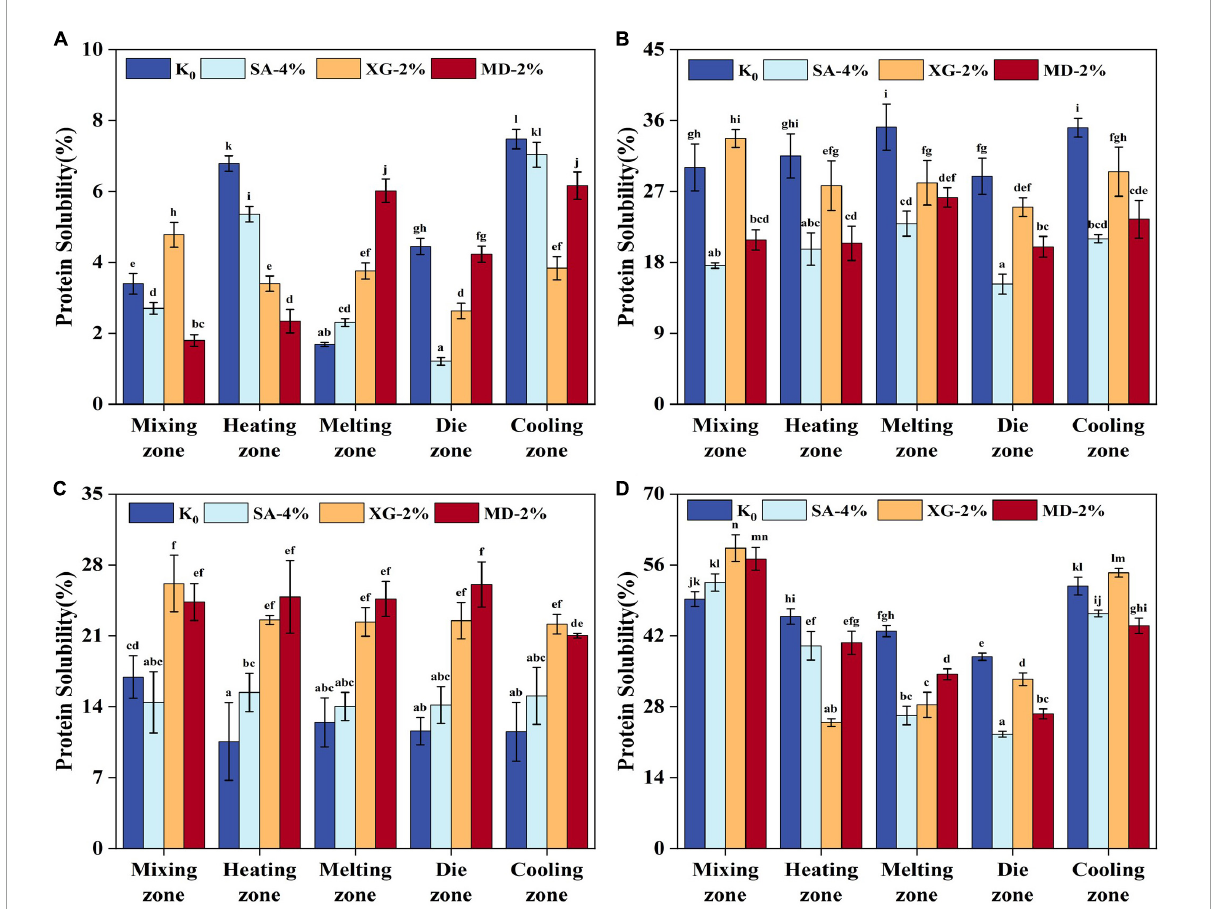
FIGURE7 Protein solubility of the extrudates in different zones (Mixing zone, Heating zone, Melting zone, Die zone, and Cooling zone) induced by extracting solutions: (A) Phosphate buffer (pH = 7.5, 0.1 mol/L). (B) 8.0 M urea in phosphate buffer (pH = 7.5, 0.1 mol/L). (C) 0.05 M dithiothreitol in phosphate buffer (pH = 7.5, 0.1 mol/L). (D) 8.0 M urea and 0.05 M dithiothreitol in phosphate buffer (pH = 7.5, 0.1 mol/L). Different letters imply significant differences between different samples separately ( P <